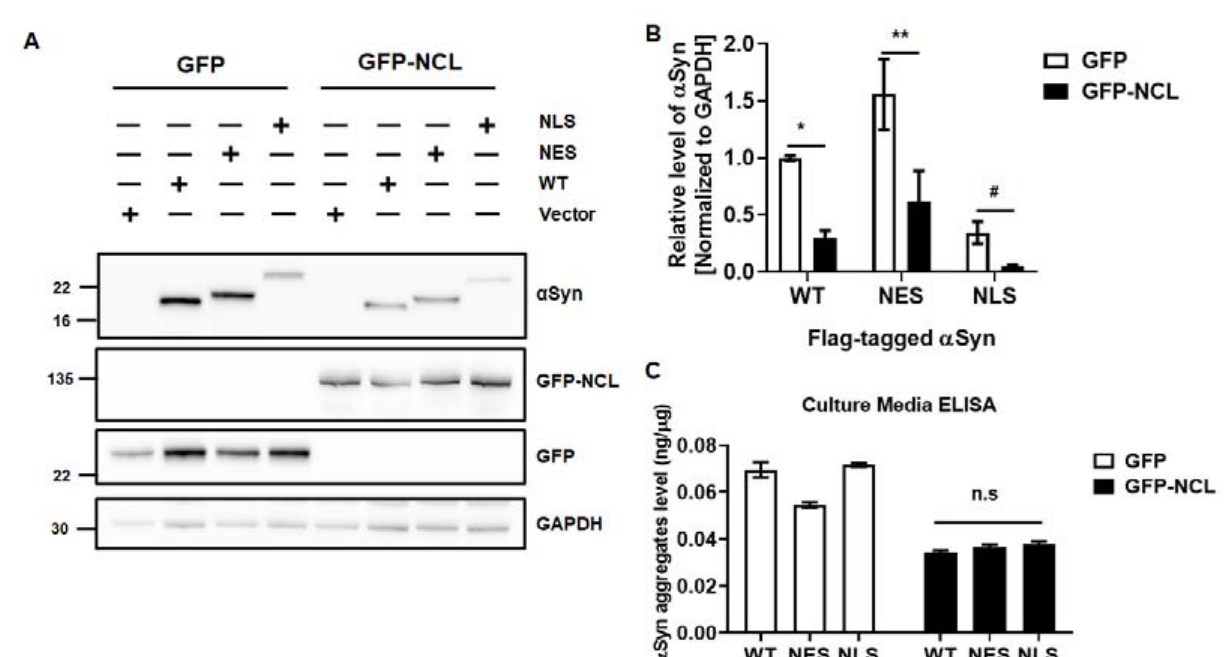
Figure 7. Ectopic expression of NCL induces the degradation of α Syn. ( A , B ) The sequential expression of ectopic GFP or GFP ‐ NCL for 24 h, following the introduction of various α Syn for 24 h, led to the degradation of the accumulated α Syn in MEF. ( C ) The culture media used during various α Syn transfection were subjected to our α Syn sandwich-ELISA. We used two-way ANOVA with Bonferroni’s post hoc test for analyzing the results obtained from Western blot analysis. Data are represented as the mean ± SEM. N = 3; * p > 0.05, ** p > 0.01, and # p > 0.05 when using unpaired, two-tailed t-test, but n.s. when using two-way ANOVA. n.s.: not significant.